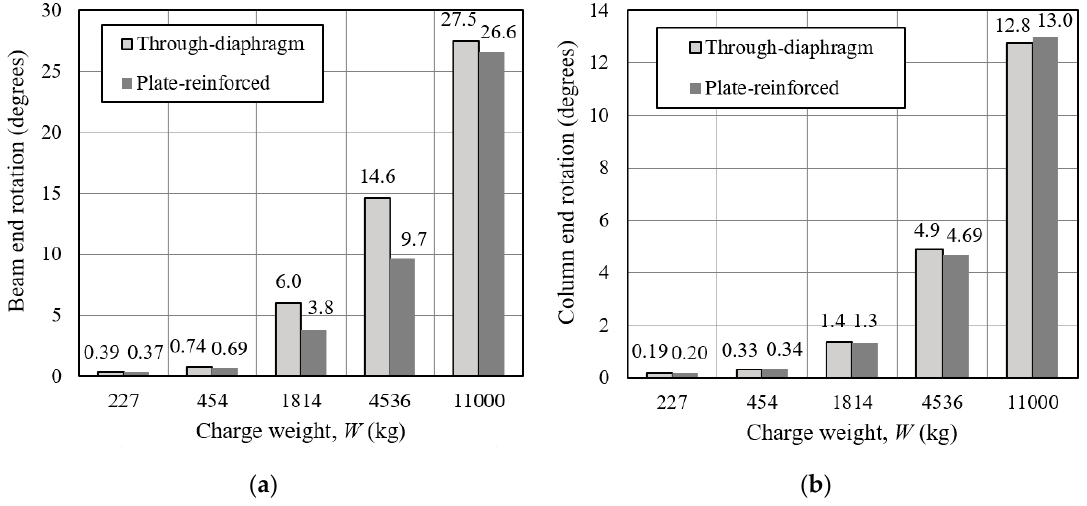
Figure 16. Comparison of end rotation between two di ff erent connections. ( a ) Beam; ( b ) column.